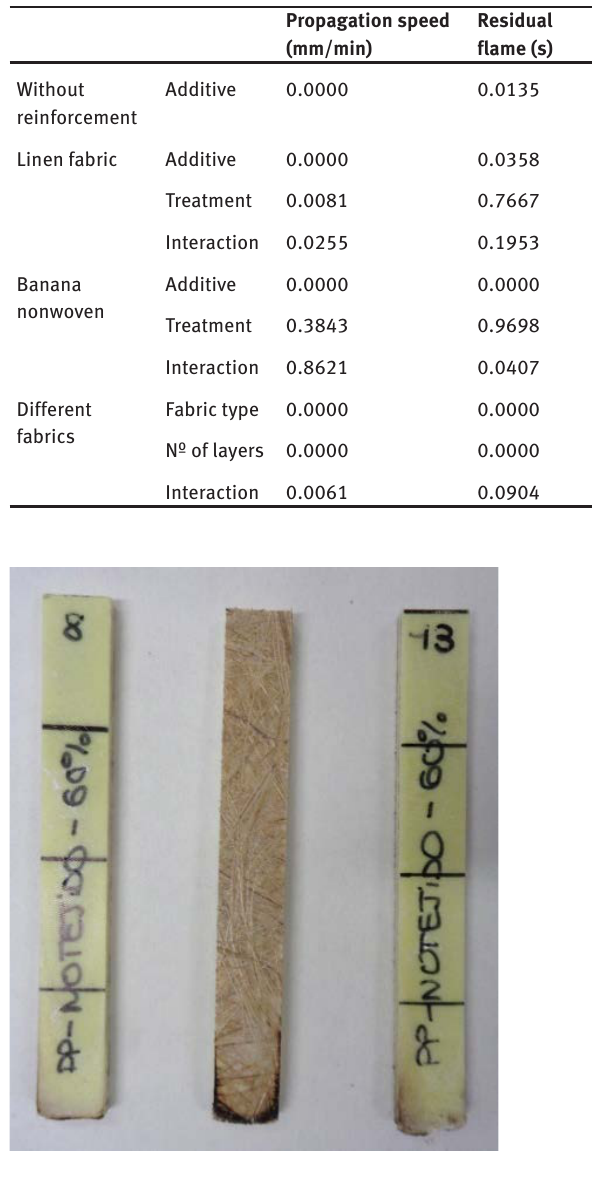
Figure 12: Samples of banana nonwoven with 60% magnesium hydroxide after fire